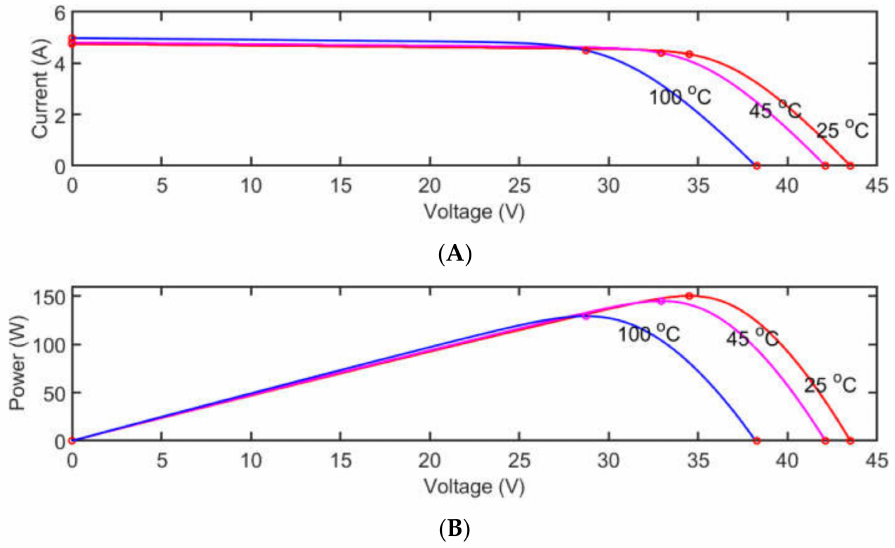
Figure 4. ( A ) Current–Voltage characteristics at constant irradiance levels and varying temperatures. ( B ) Power–Voltage characteristics at constant irradiance levels and varying